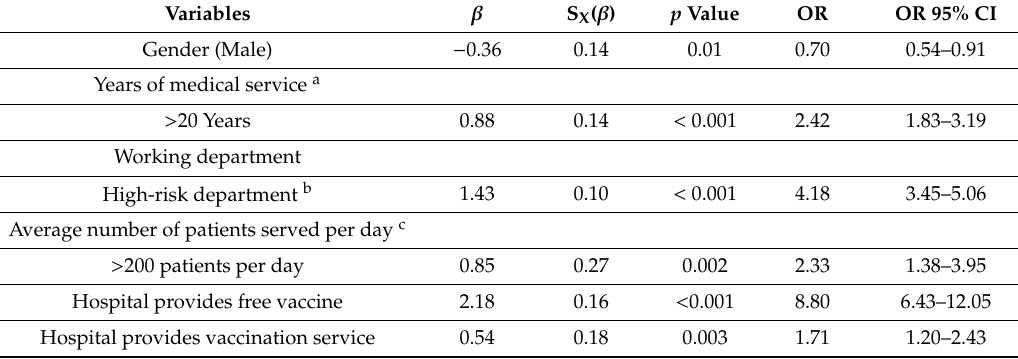
Table 1. The multiple-logistic regression results of factors associated with influenza vaccination of healthcare workers in Xining City, Qinghai, China.